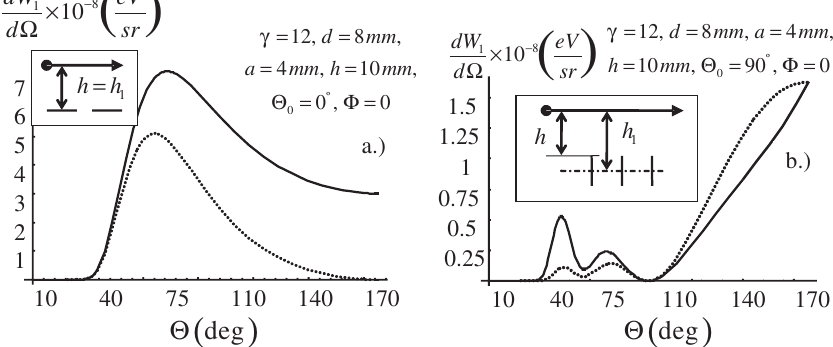
FIG. 4. Angular distribution of the SPR intensity according to the surface current model (a dotted line) and the RDR model (a solid